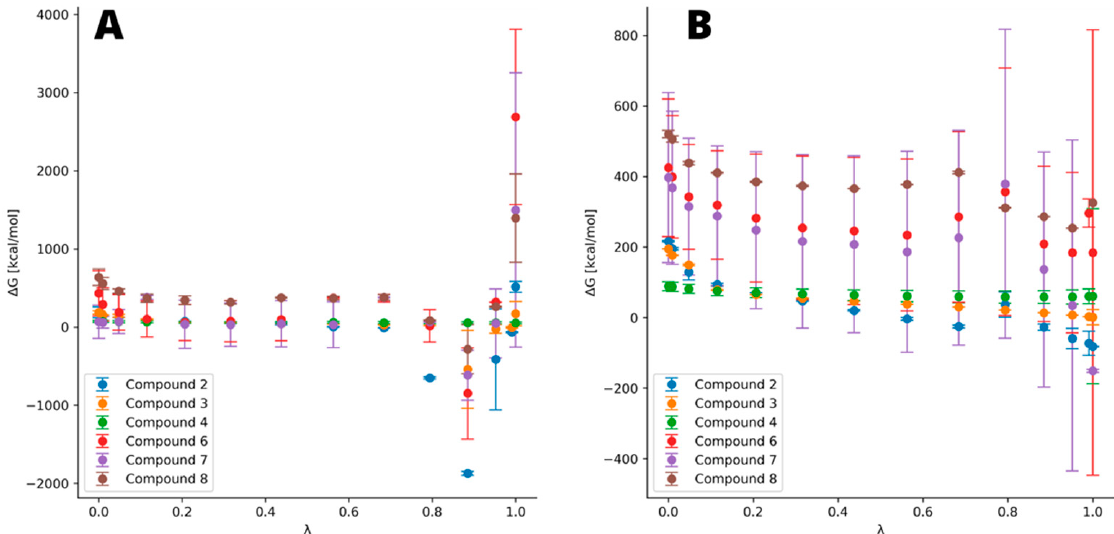
Figure 4. Free energy representation obtained at every λ . ( A ) Ligands bound to the complex and ( B ) free ligands in water box. The higher the ∆ G nearby λ of 0.8 and the steeper the slope of curve, the higher the difference in total ∆∆ G . Notable deviations are observed for drugs (compounds 6 – 8 ), which indicate their lesser stability but is also expected due to their significantly bigger structure. Table 3. Amino acids with contribution to substrate binding energy lower than − 5 kcal/mol. Ligand